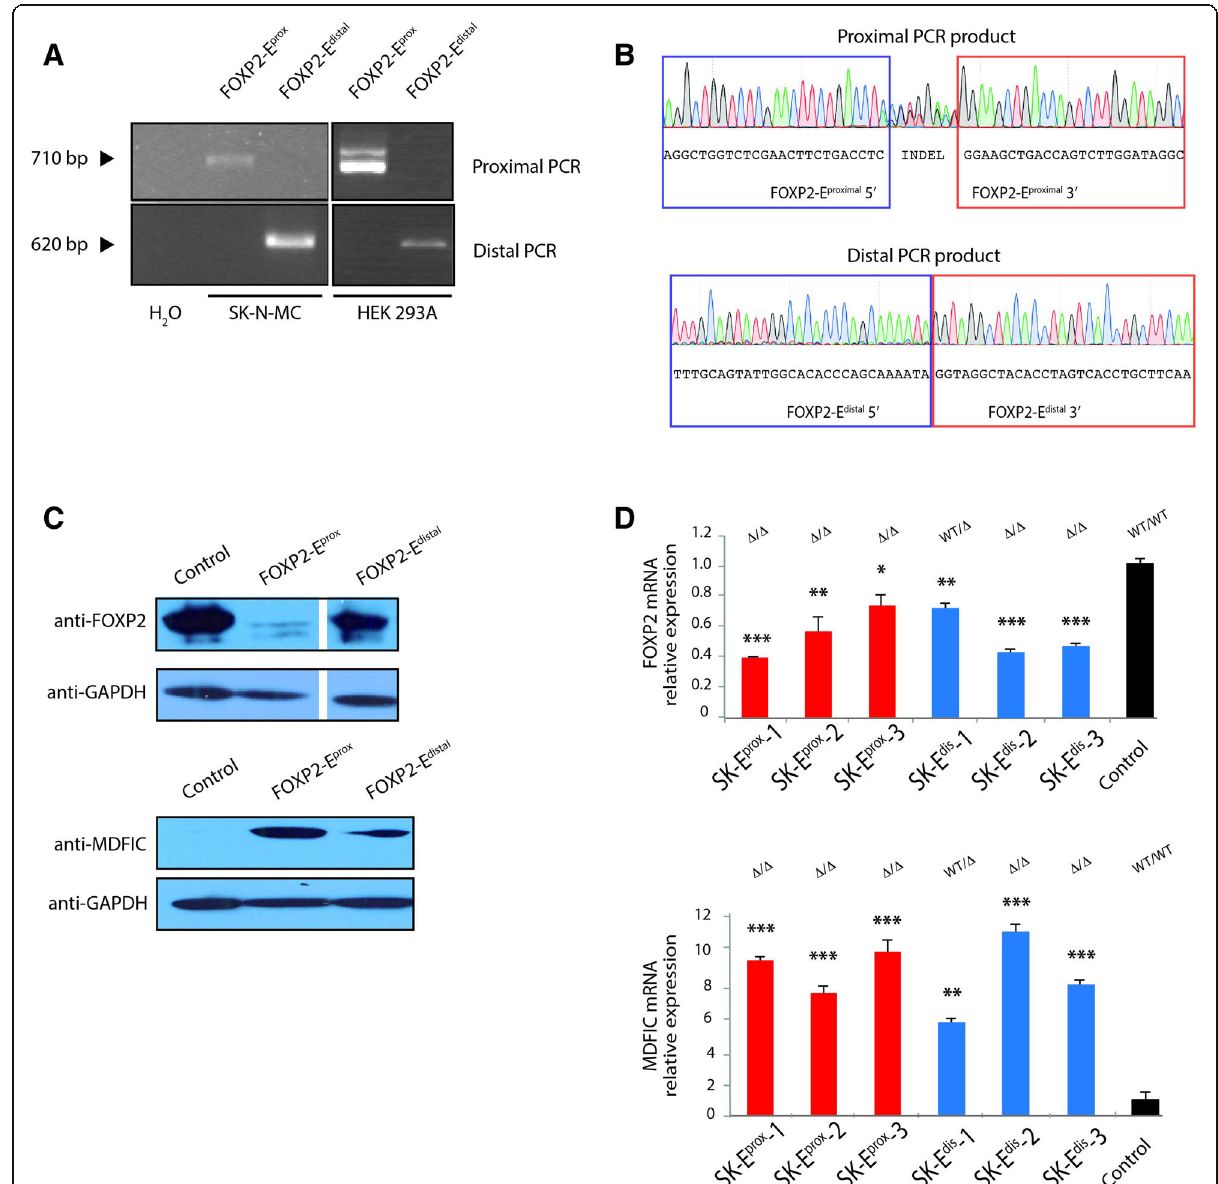
Fig. 2 Molecular characterization of FOXP2-E proximal and FOXP2-E distal . a . PCR analysis. Two oligos flanking the deleted regions were used to amplify the genomic DNA from two FOXP2-E proximal and two FOXP2-E distal deleted representative SK-N-MC and HEK293 cells. Black triangles show the size of the PCR products. b . Representative Sanger sequencing chromatogram showing the sequences of the junctions of the FOXP2-E proximal (top) and FOXP2-E distal (bottom) genomic deleted regions in a SK-N-MC cells. c. Western blot analysis of cell lysates of SK-N-MC with FOXP2- E proximal deleted, with FOXP2-E distal deleted, and of SK-N-MC control cells electroporated with pLV-U6 # H1 # -C9G plasmid for FOXP2 (top) or MDFIC (bottom) proteins analysis. d . qRT-PCR analysis in triplicate as technical replicates of six SK-N-MC cell clones with FOXP2-E proximal or FOXP2-E distal deletions, control cells are SK-N-MC cells electroporated with the pLV-U6 # H1 # -C9G plasmid. Both deleted and control values are normalized to those of the internal reference gene hGUSB. Levels of expression of FOXP2 (up) and MDFIC (down) are represented by the fold change relative to that of empty vector control cell line, which was normalized to 1. Data from three or more independent experiments were analysed by two- tailed unpaired t-test. NS, non-significant; * p < 0.05; ** p < 0.01; *** p < 0.001; and **** p <